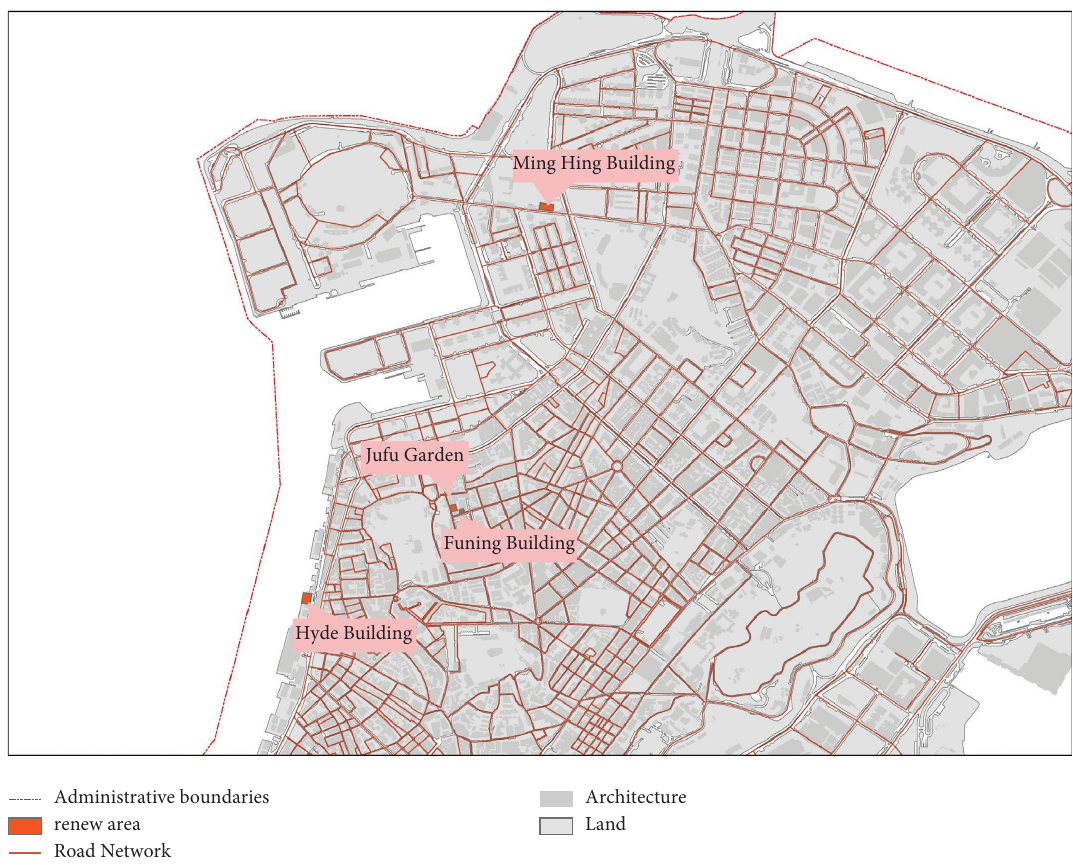
Figure 2: Overview of the study area (source: self-drawn by the